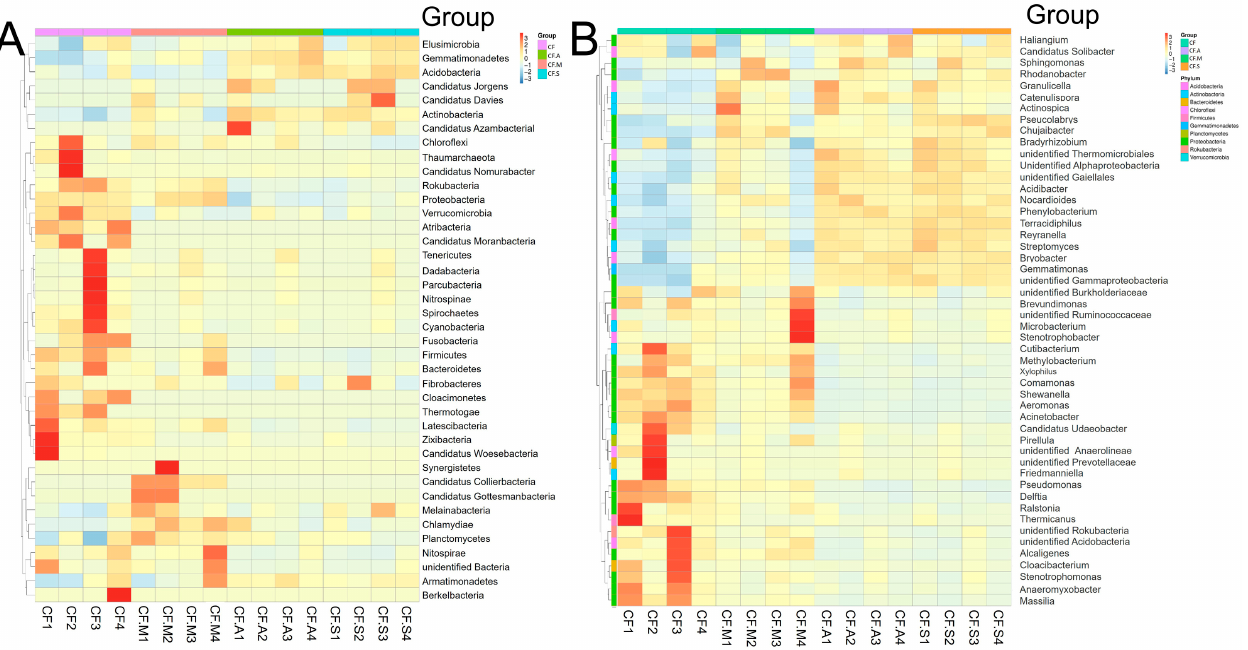
Figure 7. Heatmaps based on representative bacterial statistics of RDA-identified OTUs in the CF group (CF, CF.M, CF.A, CF.S). ( A ) Heatmaps based on representative bacterial statistics of RDA-identified OTUs in the CF group at the phylum level. ( B ) Heatmaps based on representative bacterial statistics of RDA-identified OTUs in the CF group at the genus level.